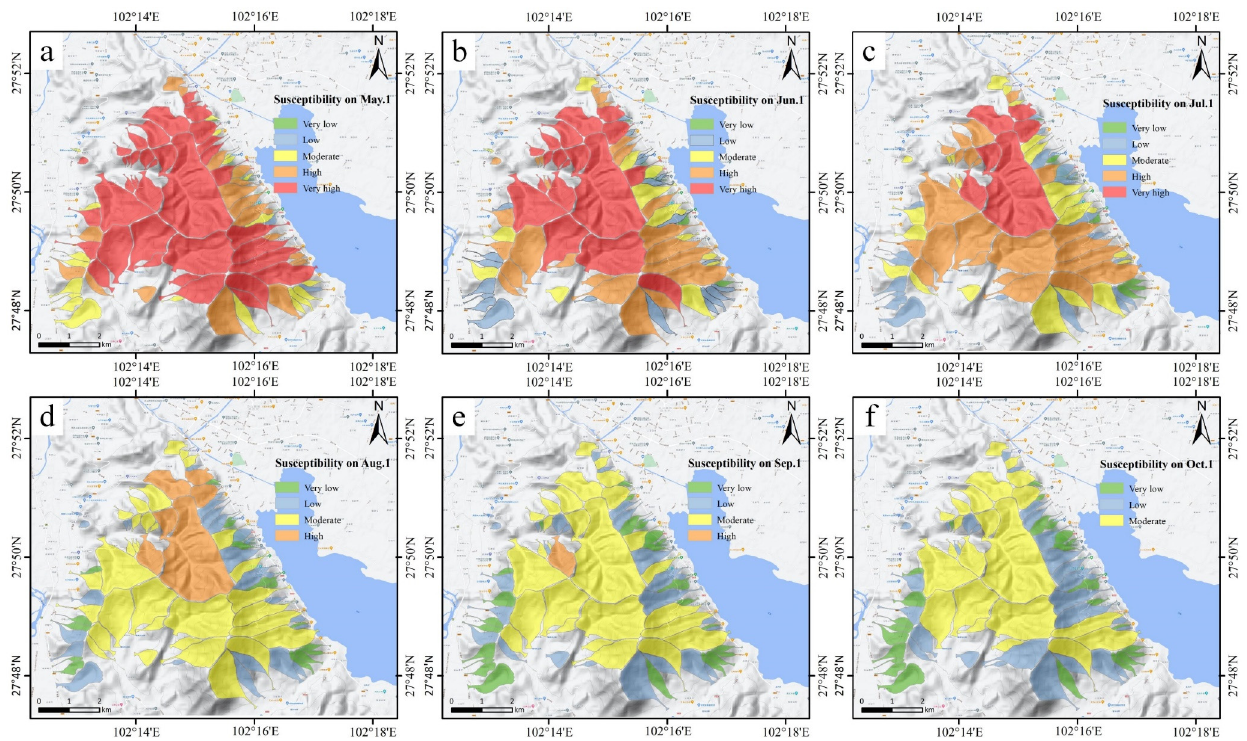
Figure 14. PFDF susceptibility mapping results of 82 watersheds in the study area in different post- fire periods. ( a – f ): susceptibility mapping results of 1 May, 1 June, 1 July, 1 August, 1 September, and 1 October respectively.